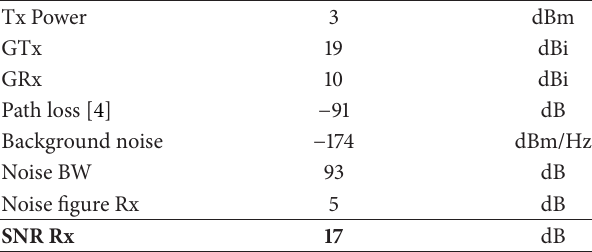
Figure 4: Single element suspended patch antenna. Table 1: Example link budget parameters.